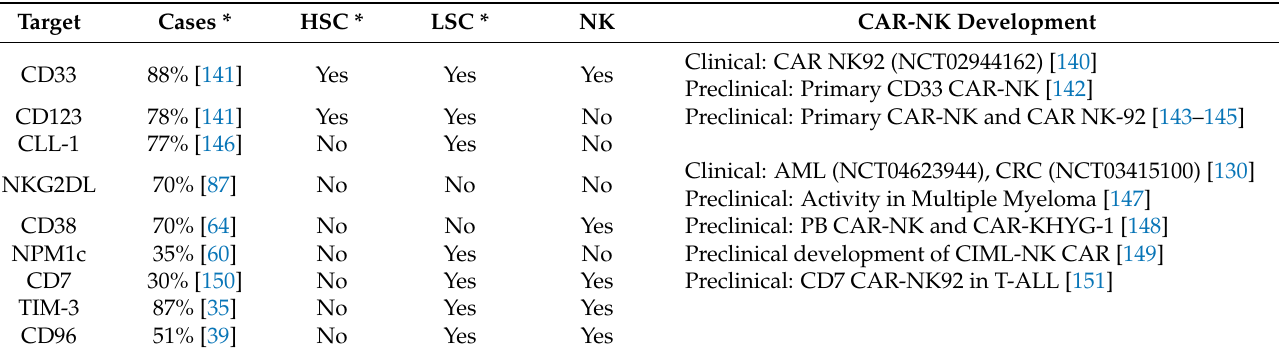
Table 3. Expression patterns and CAR-NK development status for prominent AML target antigens. CRC = colorectal cancer.